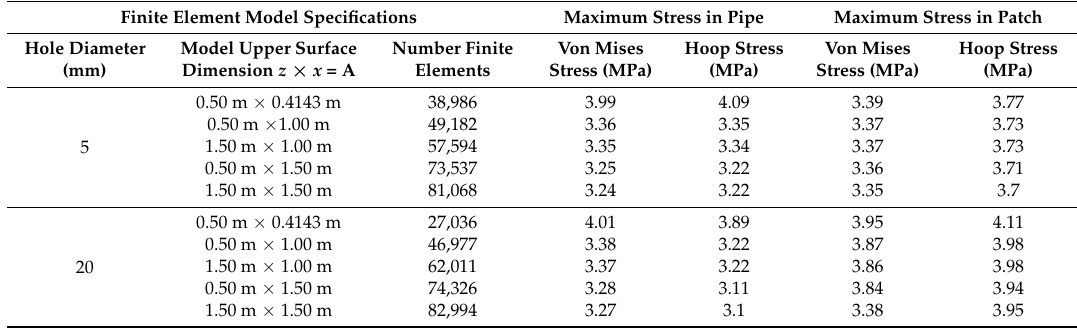
Table 7. Simultaneous effect of soil column weight and internal pressure on maximum hoop and Von Mises stresses in defected pipe and patch for various x and z values.